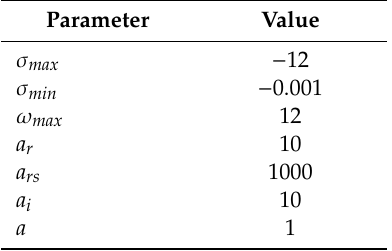
Table A3. Parameters of the fitness function.